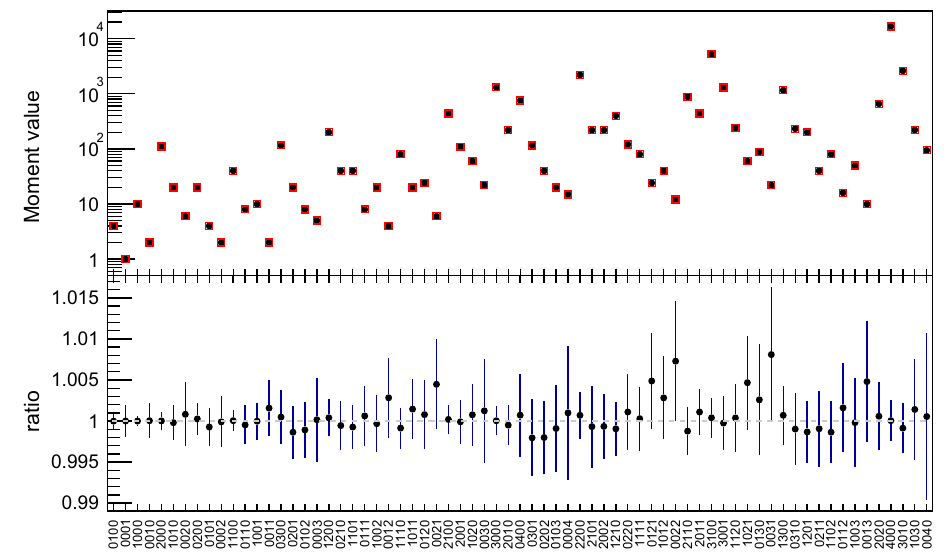
Fig. 3 Reconstructed (black circles) and generated (red squares) moments and their